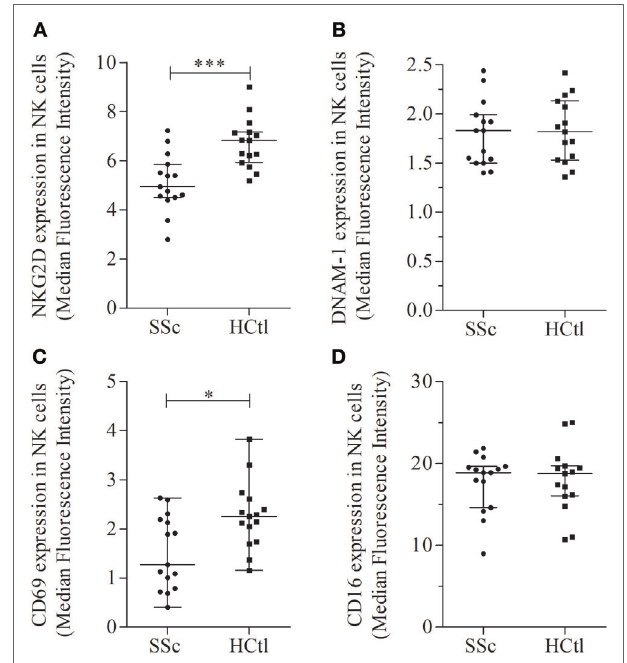
FigUre 5 | Activation receptors and markers in natural killer (NK) cells of systemic sclerosis (SSc) patients. NKG2D (a) , DNAM-1 (b) , CD69 (c) , and CD16 (D) expression levels were evaluated with flow cytometry analysis of NK cells among peripheral blood mononuclear cells from SSc patients and healthy controls (HCtl). Results were expressed as median fluorescence intensity (MFI) and median ± interquartile range. Statistical difference was established using Mann–Whitney U test. * p < 0.05; *** p < 0.001.